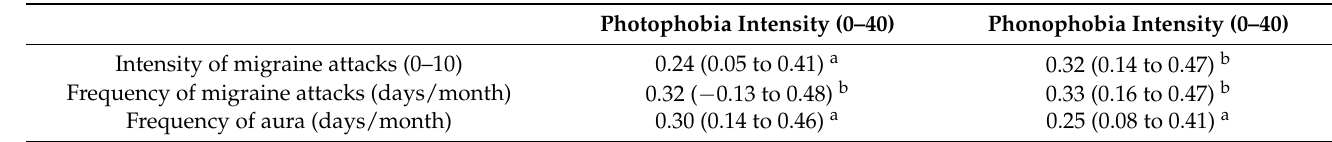
Table 4. Correlation (r, 95%confidence interval (CI)) between photo- and phono-phobia intensity and migraine features (n = 90